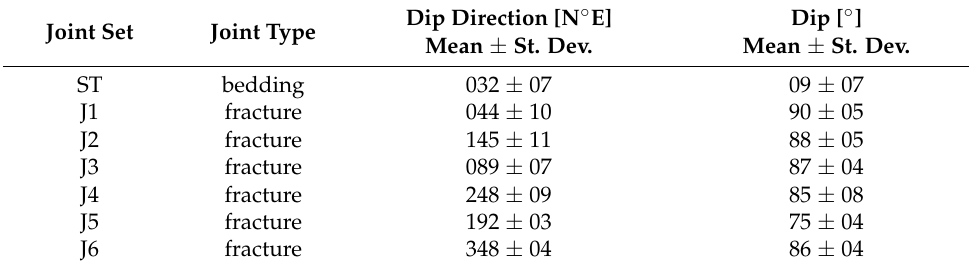
Figure 8. Rock discontinuity sets characterizing the Flysch rock mass at Debeli Rti č : ( a ) main joint sets measured on a thick sandstone layer; and ( b ) contour pole plot of joint orientation measurements. Table 5. Orientation data of measured joint sets.